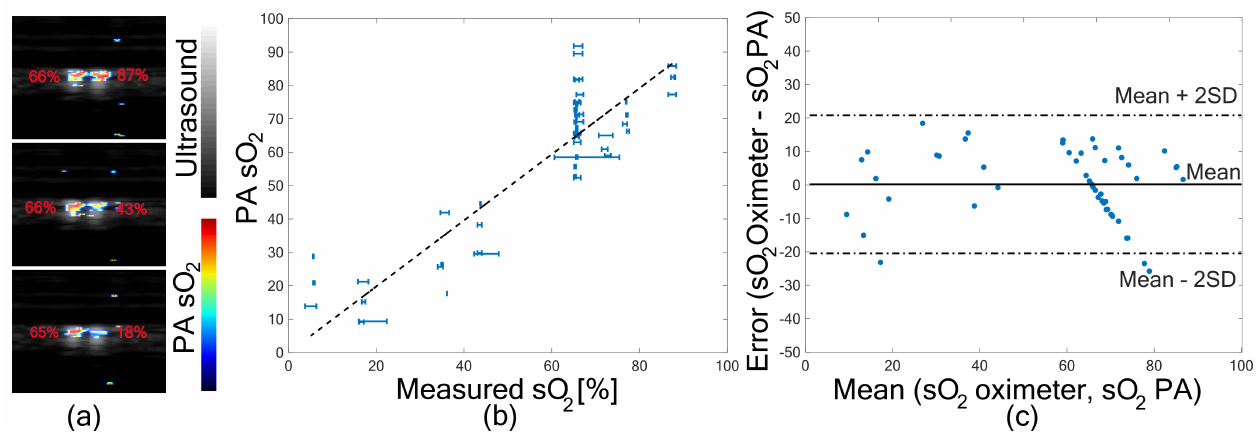
Figure 2. Photoacoustic Oxygen saturation (PA sO 2 ) validation. ( a ) PA sO 2 images from three blood oxygen levels with oximeter reading marked in the image. ( b ) PA sO 2 plotted against measured sO 2 from oximeter readings. ( c ) Error plot showing average sO 2 from oximeter values and PA sO 2 plotted against difference in sO 2 between the two